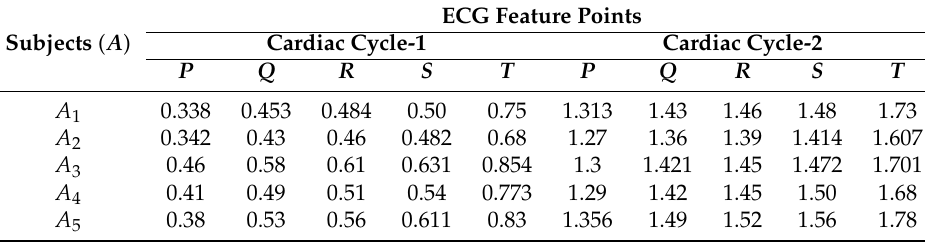
Table 11. Delineation of ECG feature points with corresponding time